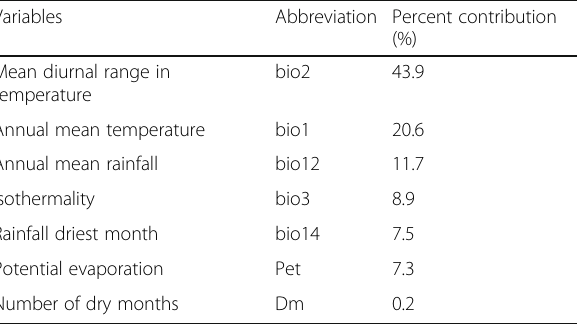
Table 1 Variable contributions in the potential distribution of V. destructor in Tanzania